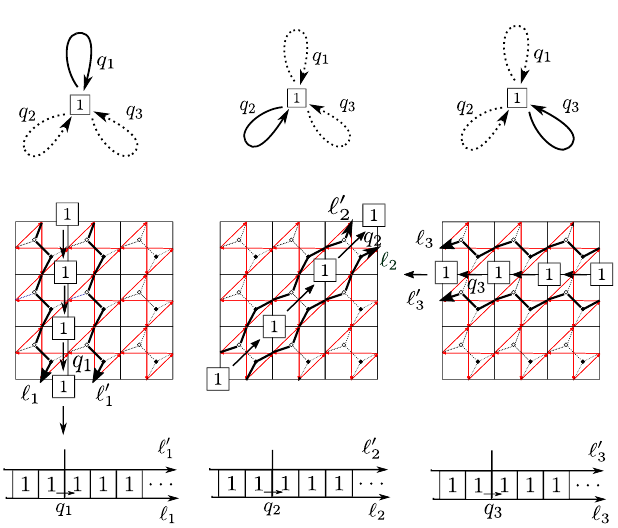
Figure 26. Subquivers and one-dimensional crystals of C 3 . The subquiver for one-dimensional crystal associated with the external leg ‘ is determined by removing arrows of m i { q i − 1 , q i +1 } , where the subindices are understood modulo 3. The resulting quiver has only one loop with parameter q . The crystal shape is determined by the region surrounded with the external i legs ‘ and ‘ 0 in the periodic quiver diagram. ‘ 0 here is the same external leg ‘ i i i fundamental region. The crystal can be illustrated as a row of boxes with coordinates q i = 1 , middle is i = 2 , and right is i = 3